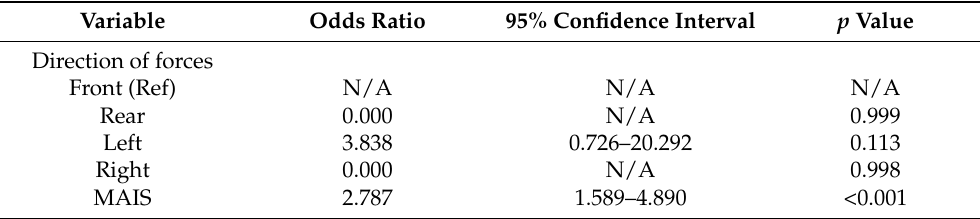
Table 4. Results of the logistic regression analysis to predict a negative fetal